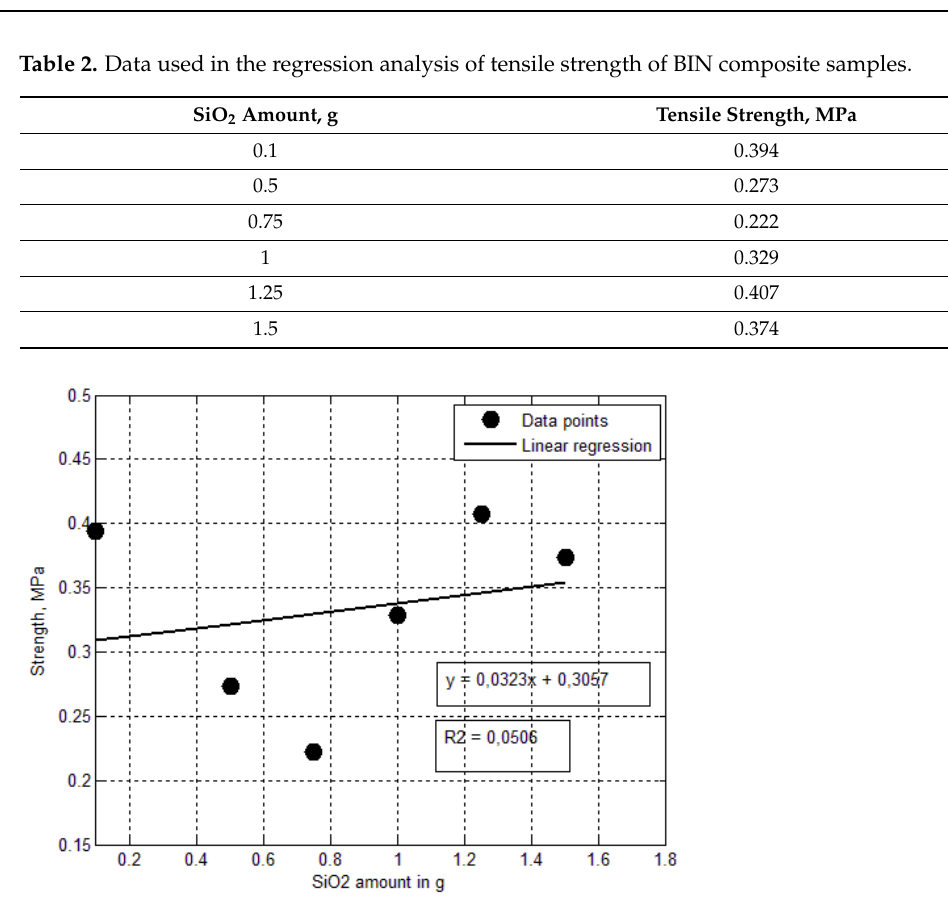
Table 2. Data used in the regression analysis of tensile strength of BIN composite samples.